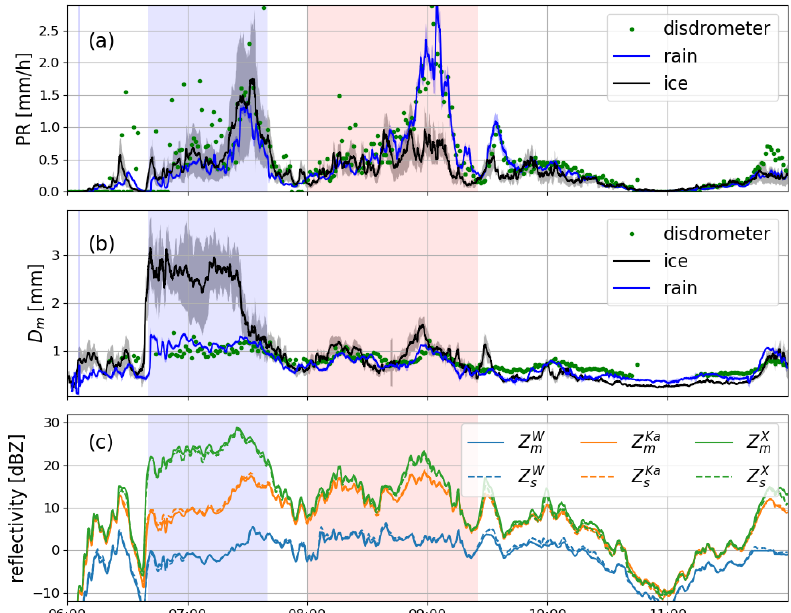
Figure 9. Results of the full Doppler spectra retrievals applied both below (Sect. 3.1) and above (Sect. 3.4) the melting zone. (a) Precipitation rate; (b) mean mass-weighted diameter; (c) measured (subscript m) and simulated (subscript s) radar reflectivity values in the ice region just above the freezing level. The green dots in panels (a) and (b) correspond to the disdrometer measurements at the ground. Shading around the retrievals shows the uncertainty (1 standard deviation) of the posterior